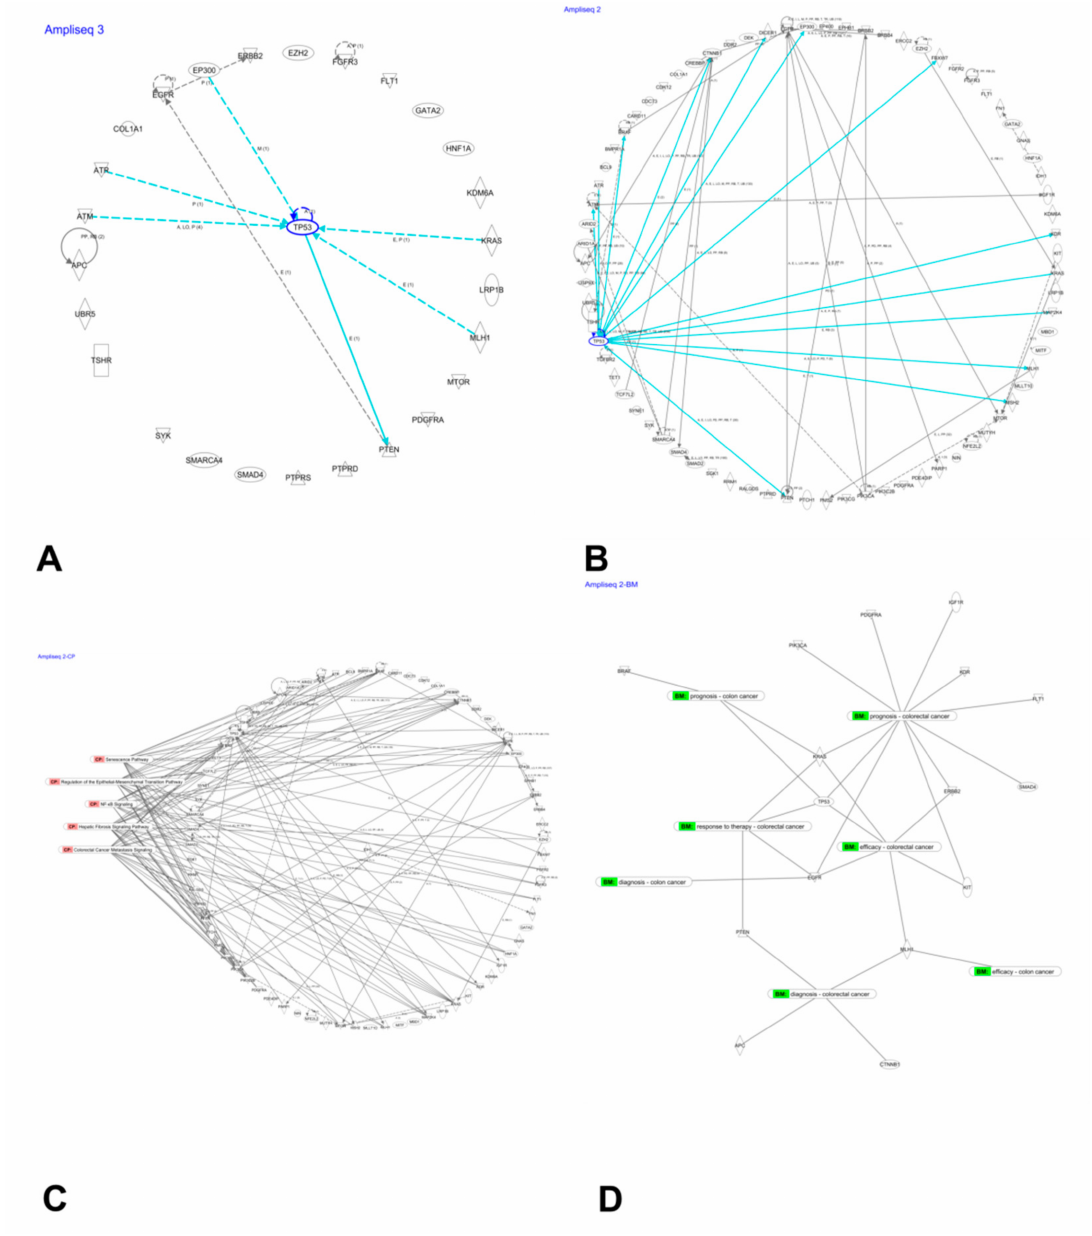
Figure 6. Network analyses of genes with reported variants. Network of 27 most frequently mutated genes ( A ). Network of 75 genes harboring pathogenic mutations reported in the large intestine ( B ). Association of 75 genes with canonical signaling pathways ( C ). Possible biomarker candidates for diagnosis, prognosis, efficacy, and response to drugs for colon and colorectal cancer ( D